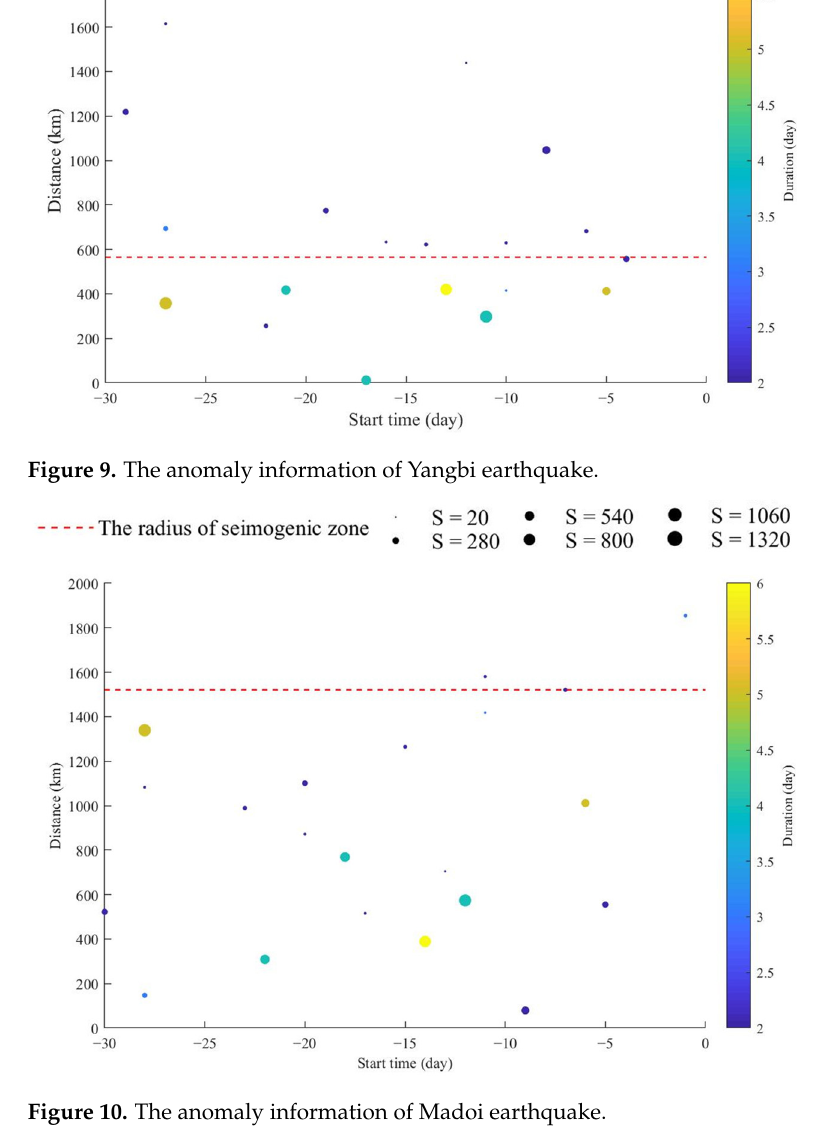
Figure 10. The anomaly information of Madoi earthquake.